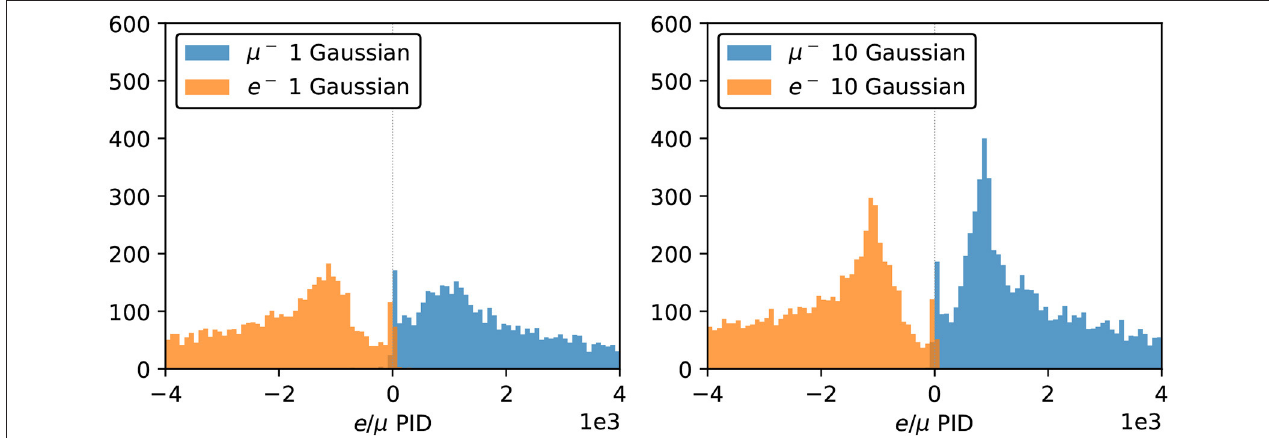
FIGURE 11 | PID performance of the 1-Gaussian (left) and 10-Gaussian (right) charge-only networks. The true electron and muon events locate in the negative and positive region, respectively, and the 10-Gaussian network shows better concentrated peaks for both particle types.